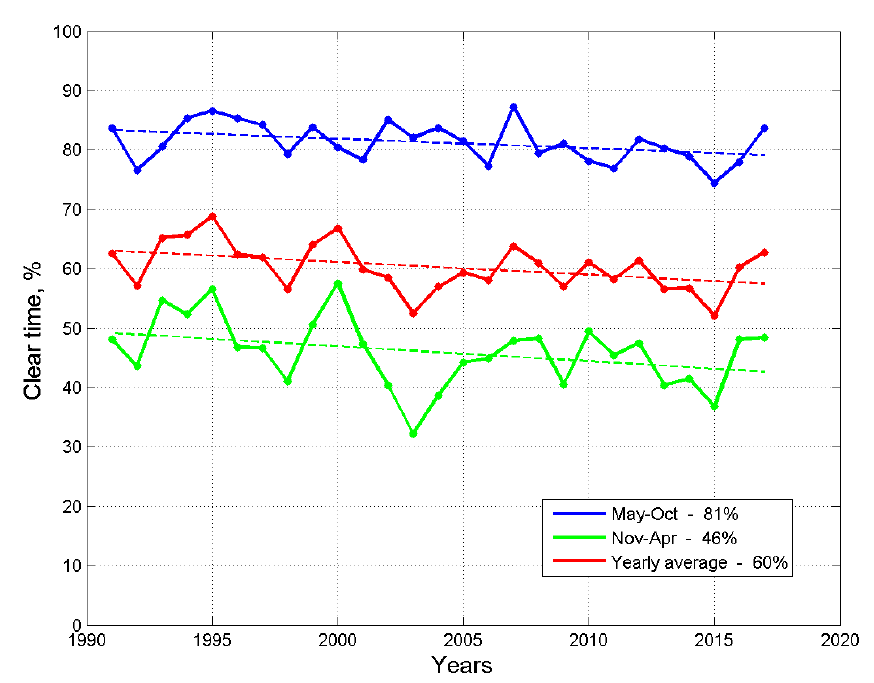
Figure 2. Long-term trends of the amount of yearly clear time.